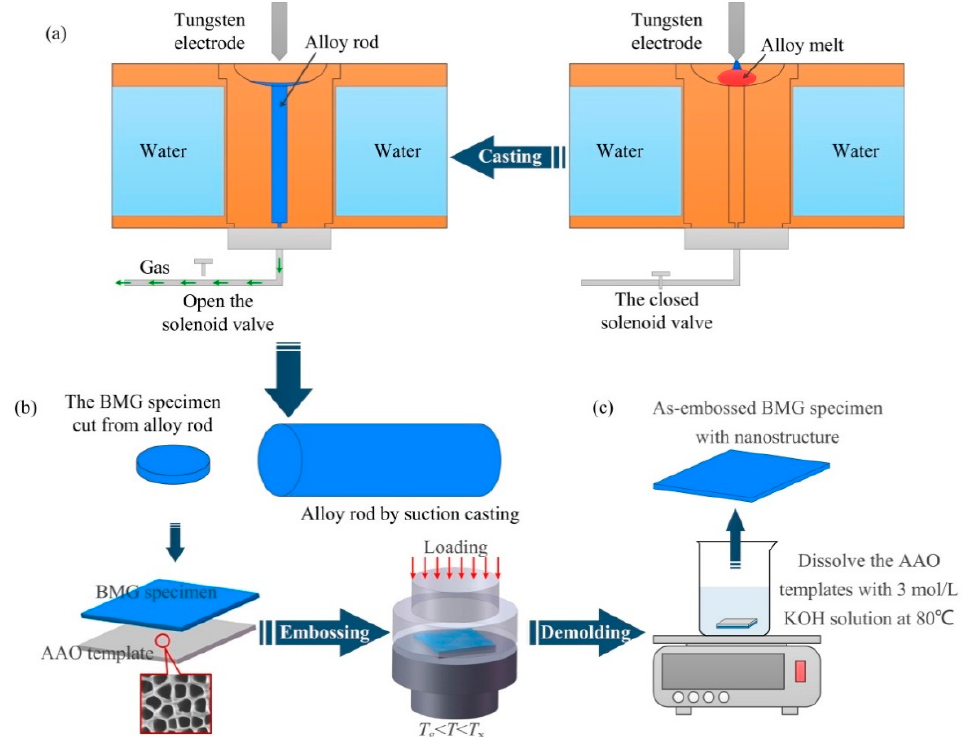
Figure 1. Preparation process of BMG nanostructure: ( a ) prepare the Zr-based BMG rods by arc melting and copper mold suction casting; ( b ) hot embossing of nanostructure on the surface of BMG specimens; ( c ) demolding process of the as-embossed BMG specimens.